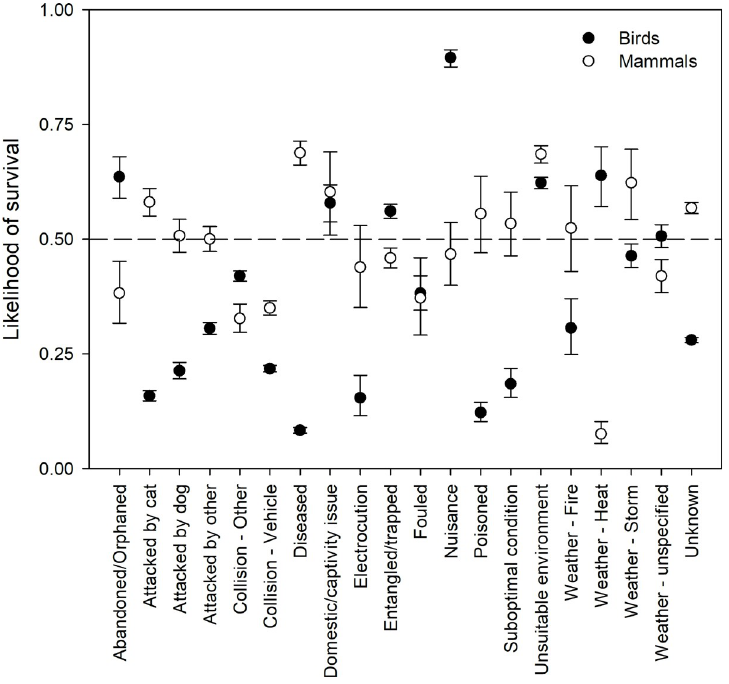
Fig 11. Likelihood of survival + 95% confidence intervals in relation to cause for rescue and animal group.